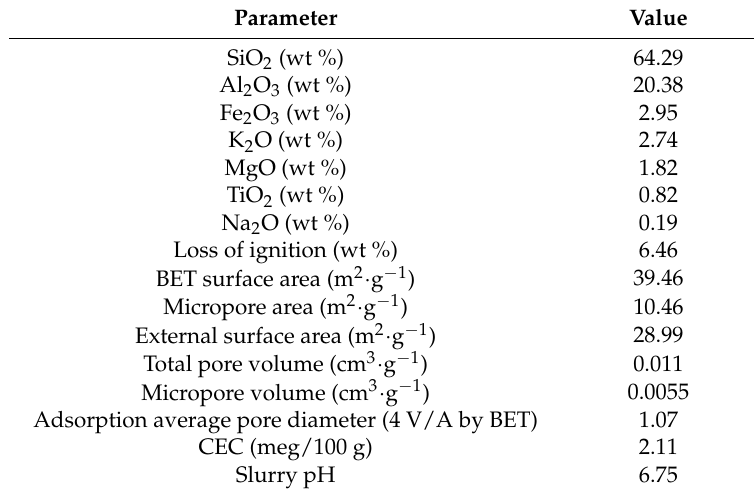
Table 1. Chemical composition and physicochemical properties of nano illite-smectite (I-S m )